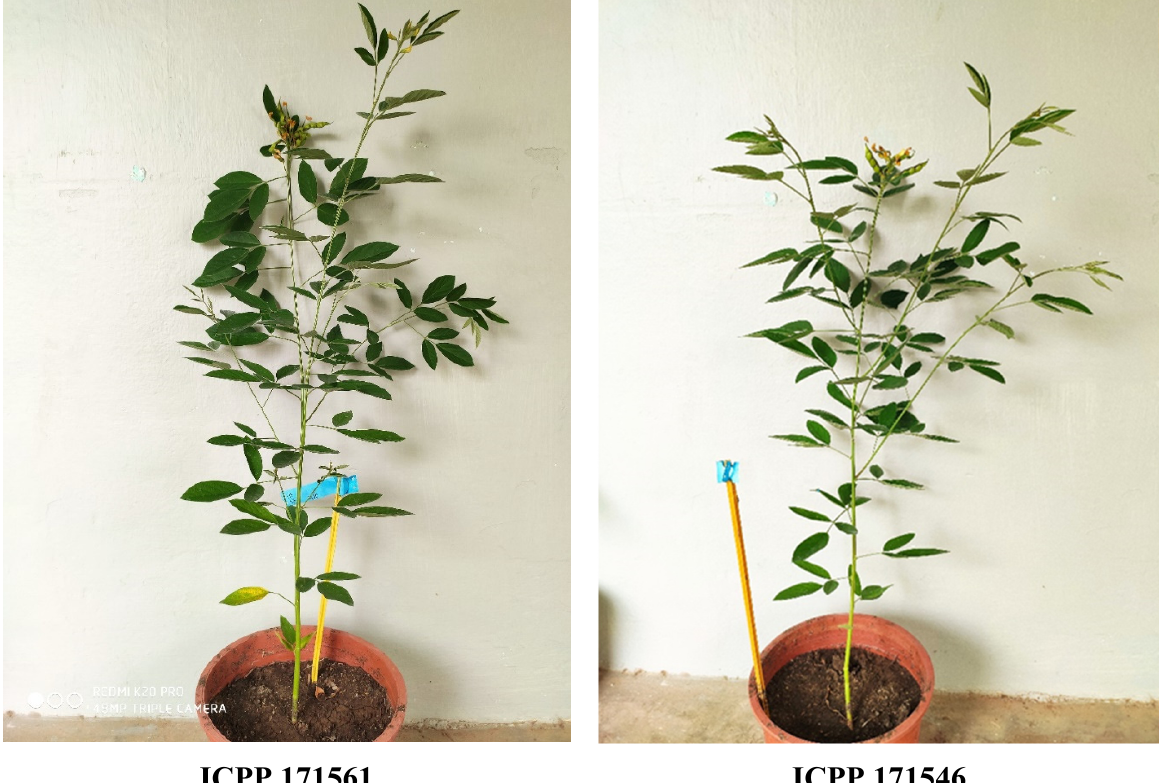
Figure 1. Photoperiod insensitive ILs .